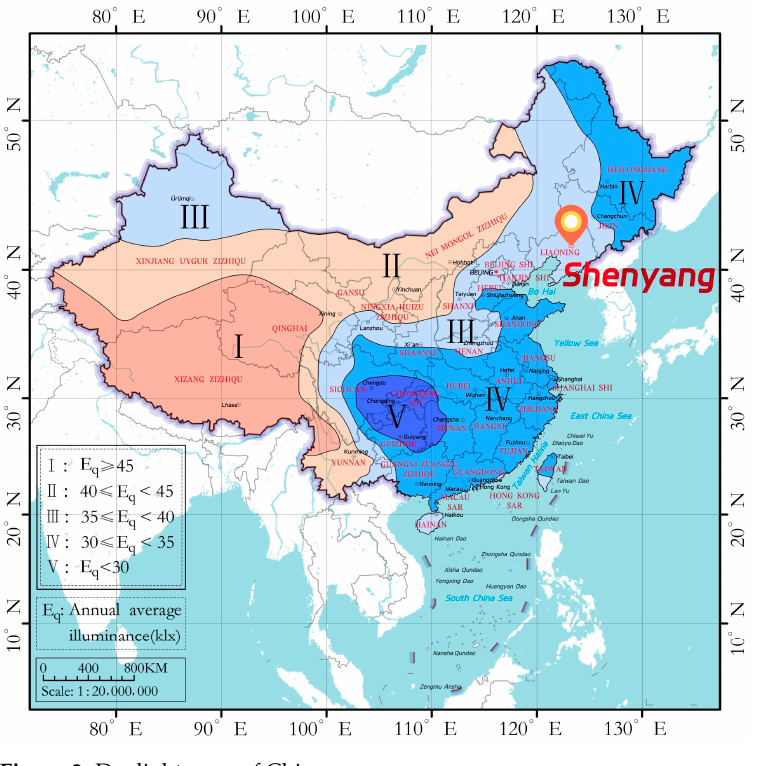
Figure 2. Daylight zone of China.